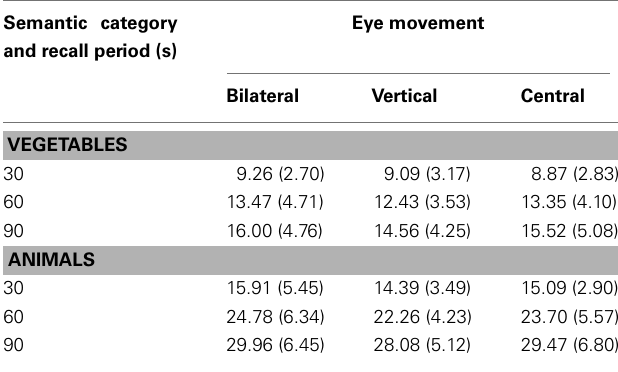
Table 4 | Mean (SD) number of semantic memories recalled as a function of eye movement condition, semantic category, and recall